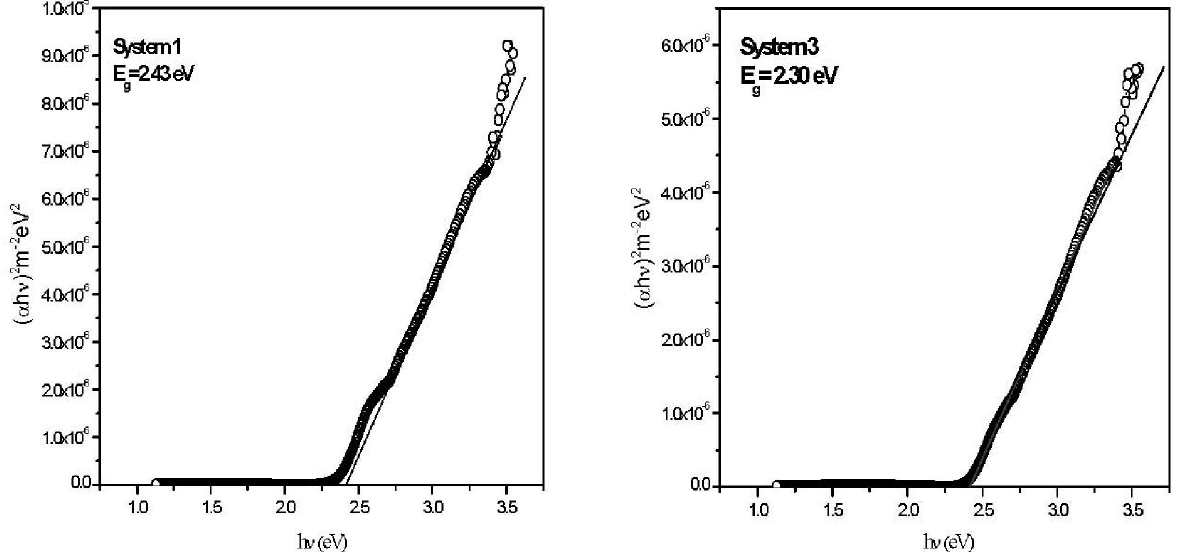
Figure 4. A typical plot of ( αhυ ) 2 versus photon energy for Systems 1 (left panel) and 3 (right).